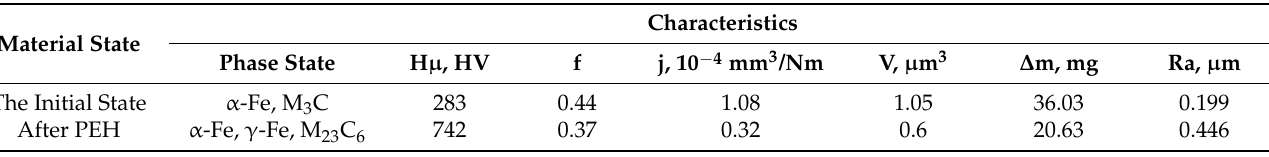
Table 1. Experimental data on the structure and tribological characteristics of 0.34Cr-1Ni-Mo-Fe steel. Material State